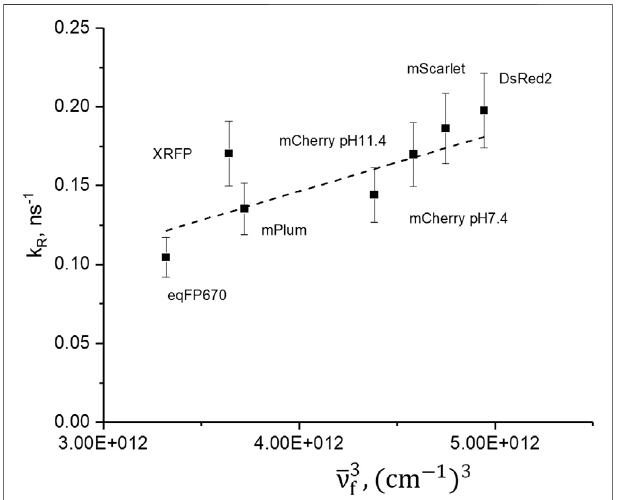
FIGURE 3 | Dependence of nonradiative decay rate (log scale) on peak fl uorescence frequency. Red circles correspond to RFPs studied here and green triangles correspond to a number of GFPs variants, studied previously (Drobizhev et al., 2011; Molina et al., 2017). The dashed lines represent linear fi ts to the two sets of